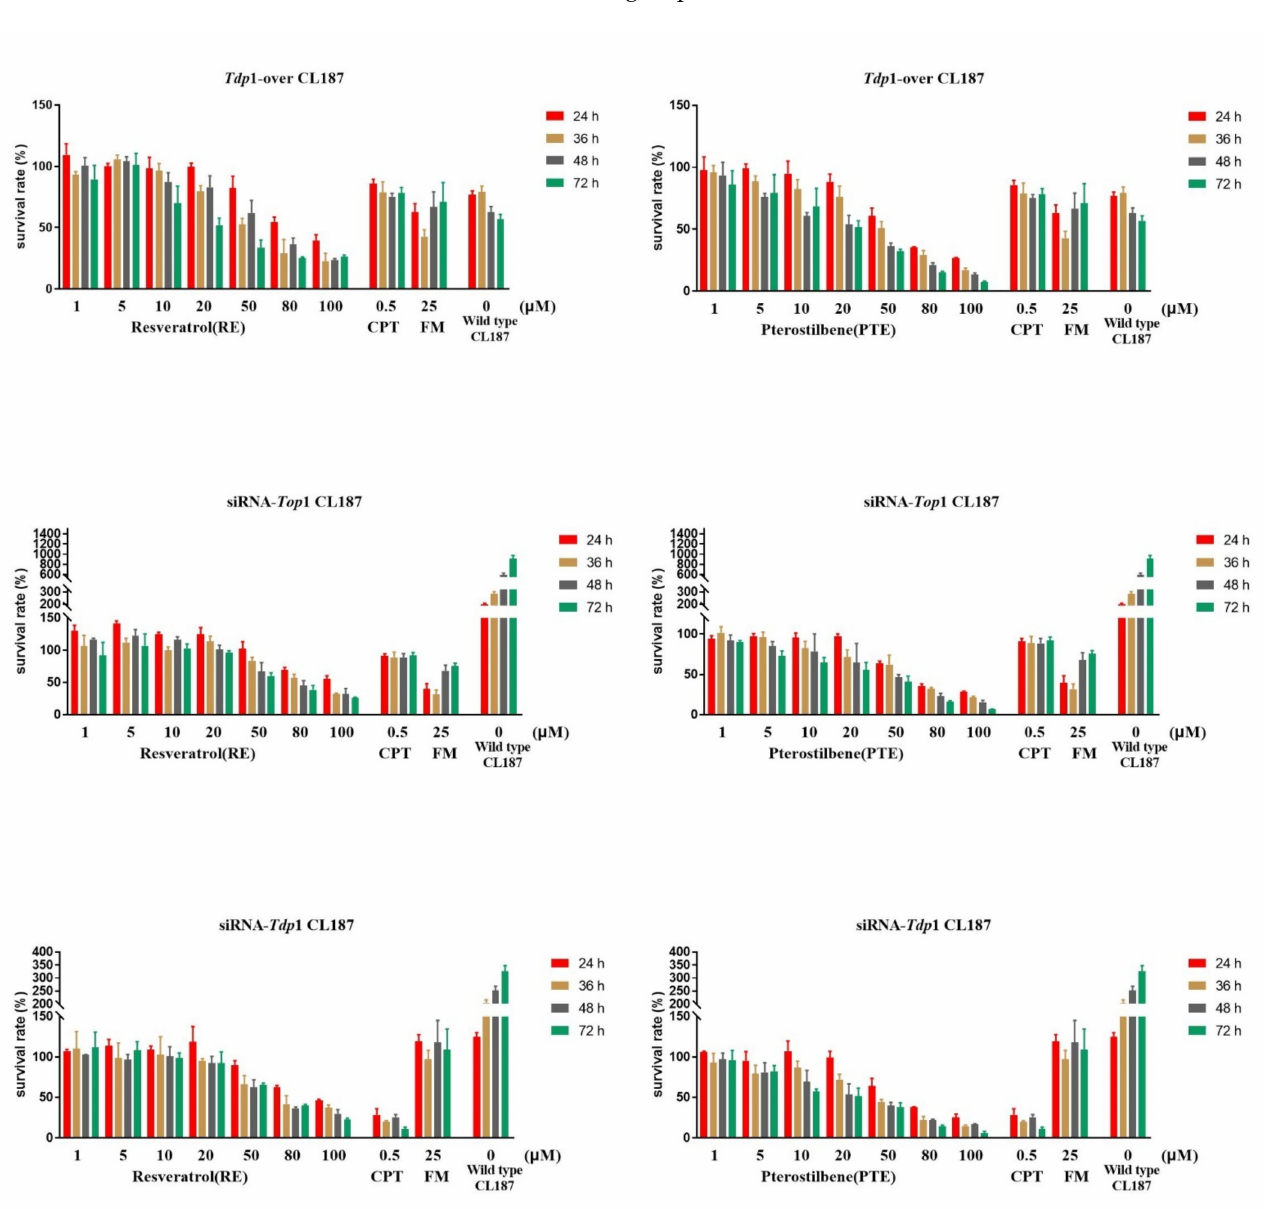
Figure 6. Cytotoxic results of Tdp 1-overexpressing and Top 1- or Tdp 1- silenced CL187 cells incubated with PTE and RE for 24, 36, 48 and 72 h. Data are mean ± SD, n =